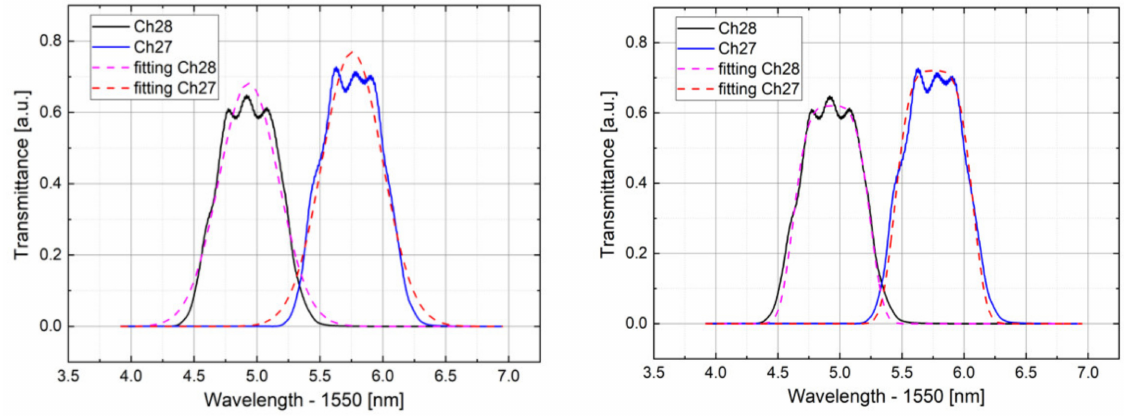
Figure 6. First-order Gaussian fitting of channel 27 and 28 ( left ). Second-order Gaussian fitting ( right ).